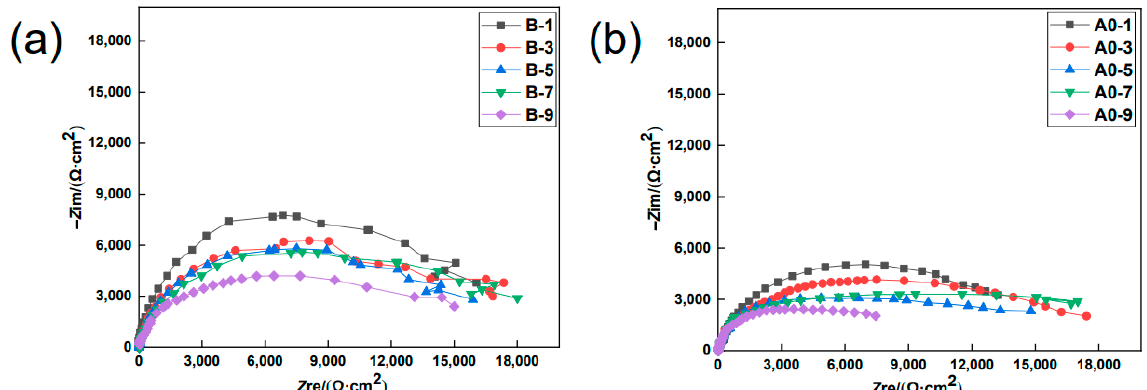
Figure 3. Nyquist plot of B ( a ) and A0 ( b ) with an increasing number of drying–wetting cycles.